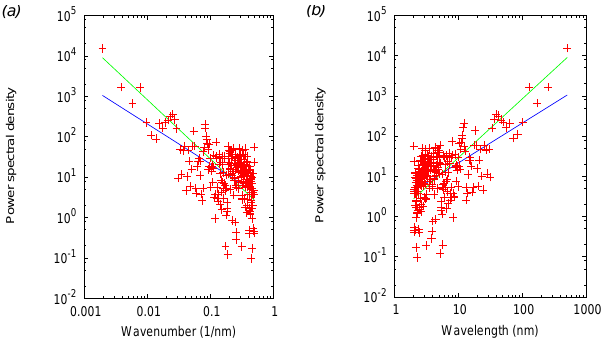
Figure 2. Power spectral density of the detrended SIF data set to- gether with the least squares fit with power-law exponent β = 0 . 99 ( ± 0.08) (blue line) and the β = 1 . 46 as determined with the Haar analysis (green line) vs. (a) the wavenumber, and (b) the wave- length.